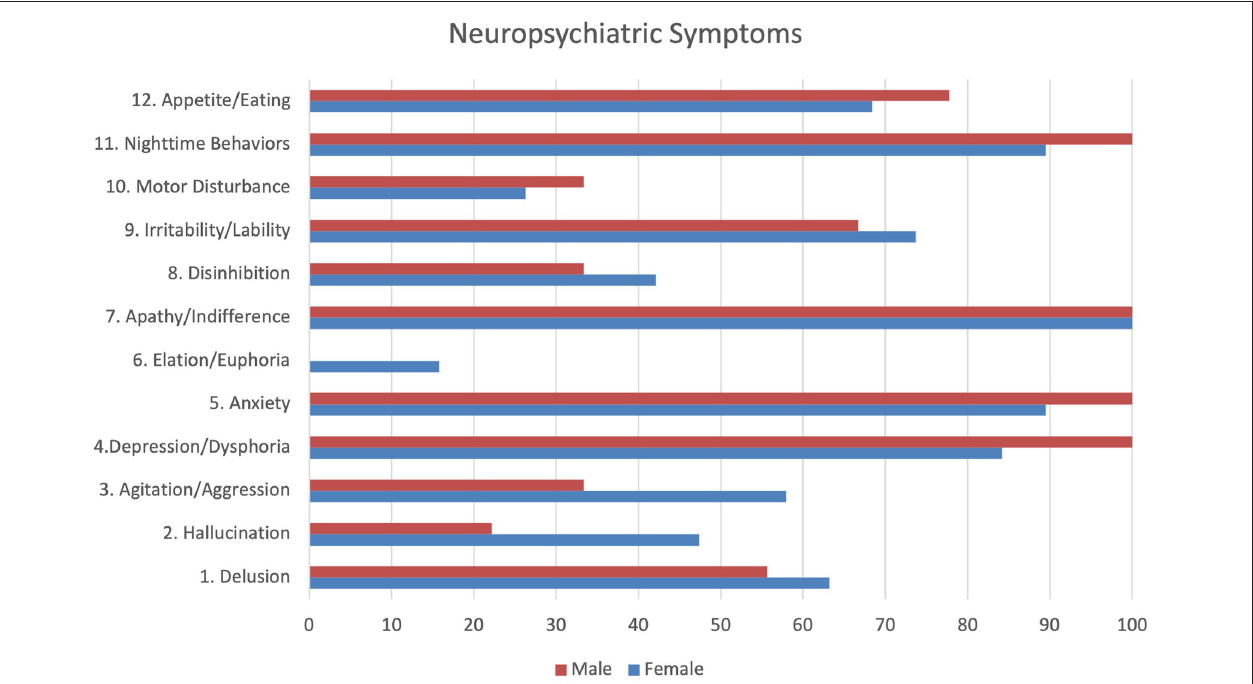
FIGURE 1 | Neuropsychiatric